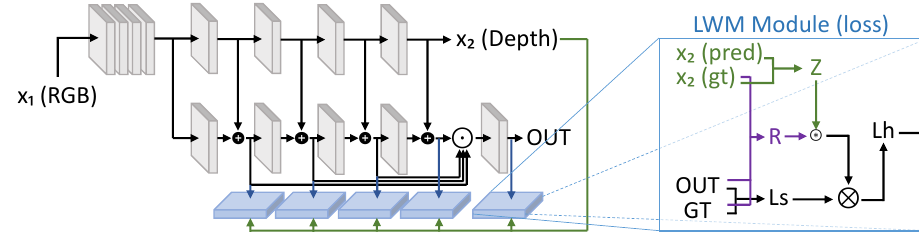
Figure 10. Architecture of [97], exploiting the LWM